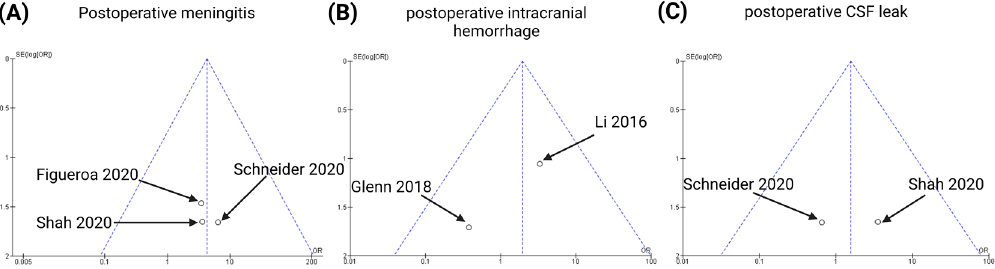
Figure 8. Funnel plots for the following endpoints of the present meta-analysis [24,29,32–34]: postop- erative meningitis ( A ), postoperative intracranial hemorrhage ( B ), and postoperative CSF leaks ( C ).